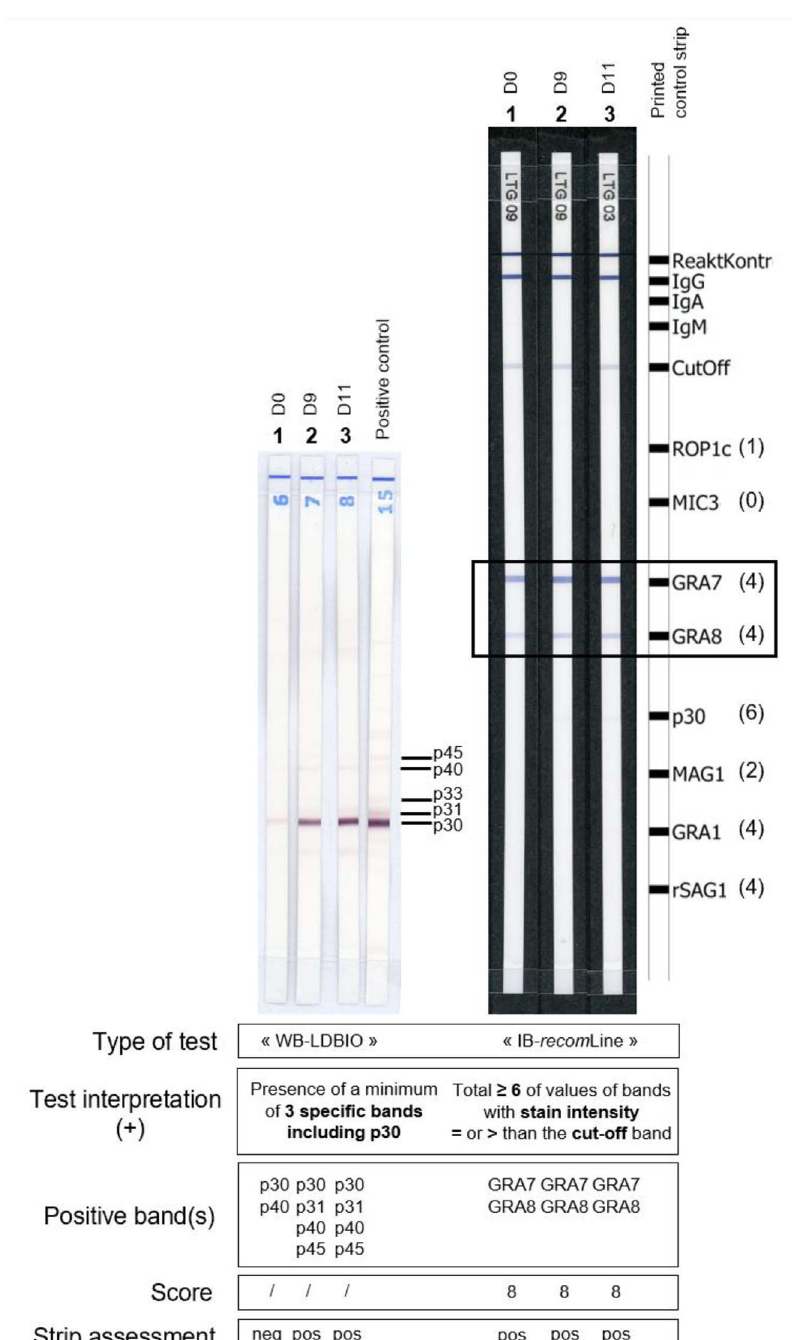
Figure 3. Example of toxoplasmic seroconversion with IgG detected earlier with IB- recom Line compared to WB-LDBIO. In this sequence of three sera belonging to the same patient: serum 1 corresponded to “ day 0 ” , serum 2 to “ day 9 ” , and serum 3 to “ day 11 ” . The number of points reported by positive bands with IB- recom Line is speci fi ed in parentheses. Neg = negative result; pos = positive